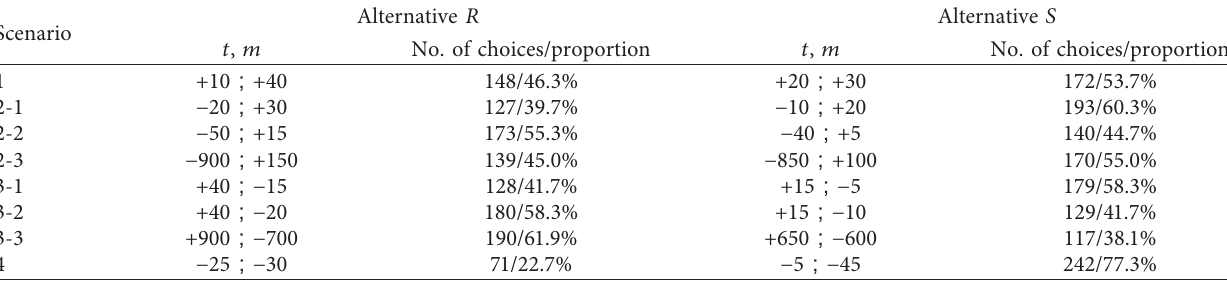
Table 1: Travel choice results under deterministic conditions.